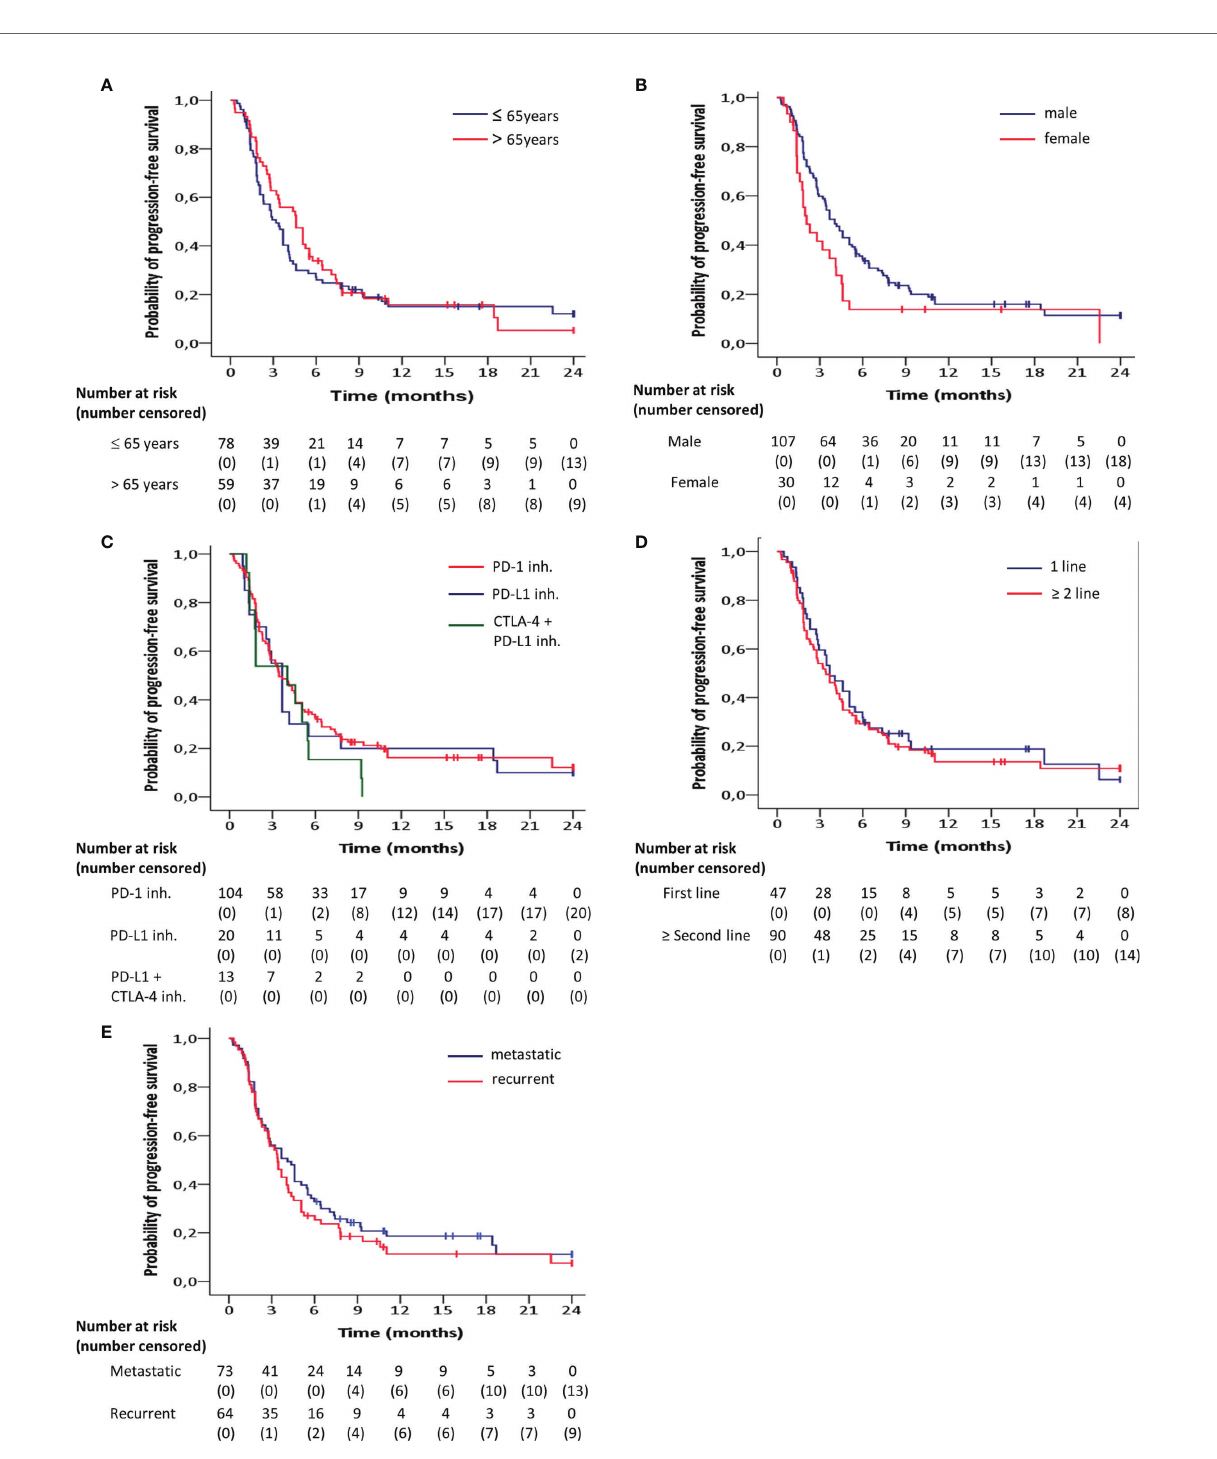
FIGURE 3 | Kaplan-Meier curves for progression-free survival according to (A) age, (B) gender, (C) target inhibitor, (D) line of treatment, (E) pattern of recurrence, estimated for the entire patient group (n=137). Progression-free survival was signi fi cantly (p<0.05) longer in men compared to